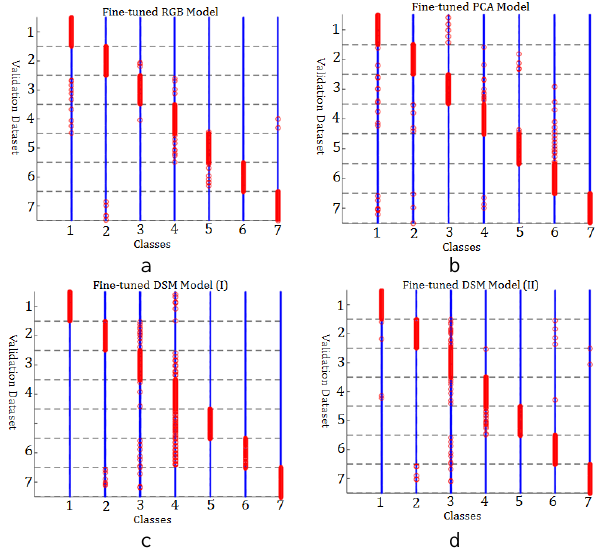
Figure 4. Comparison of maximum scores for validation data in each class based on different trained models: a: fine-tuned RGB model, b: PCA model, c: fine-tuned DSM model, d: fine-tuned DSM model initialized by RGB model, (1: Complex, 2: Flat, 3: Gable, 4: Hip, 5: Pyramid Hip, 6: Mansard, 7: Non roof)